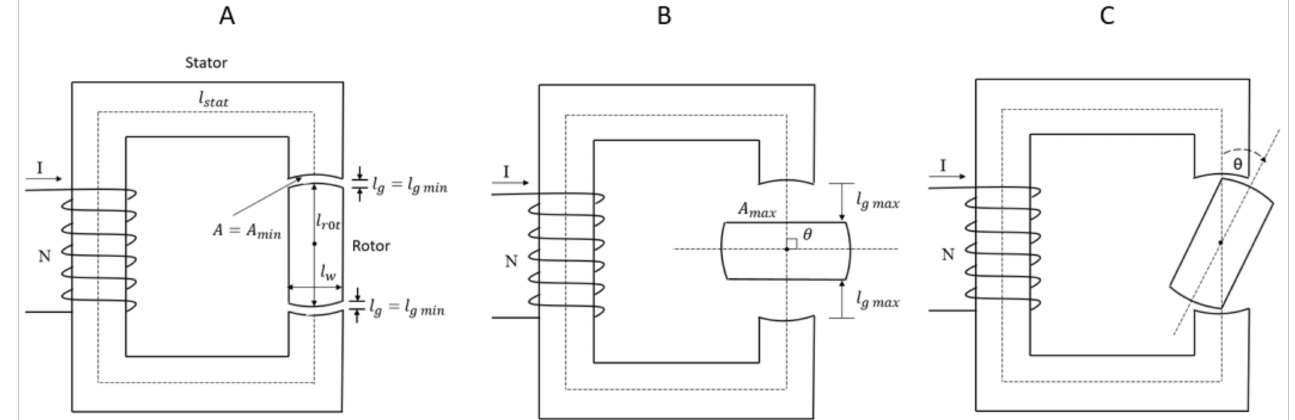
Figure 1. A simplified magnetic circuit consisting of a stator and rotor. The rotor’s axis is directed perpendicular to the paper plane. ( A ) The magnetic axis of the stator and that of the rotor is aligned. ( B ) The magnetic axis of the rotor is perpendicular to the magnetic axis of the stator. ( C ). There is an angle θ between the magnetic axis of the stator and the rotor